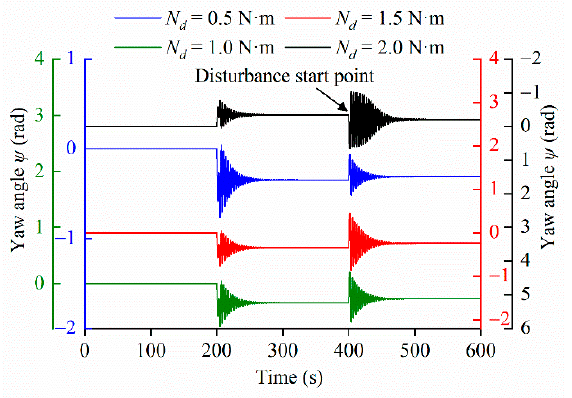
Figure 17. Variation of yaw angle after an external disturbance.